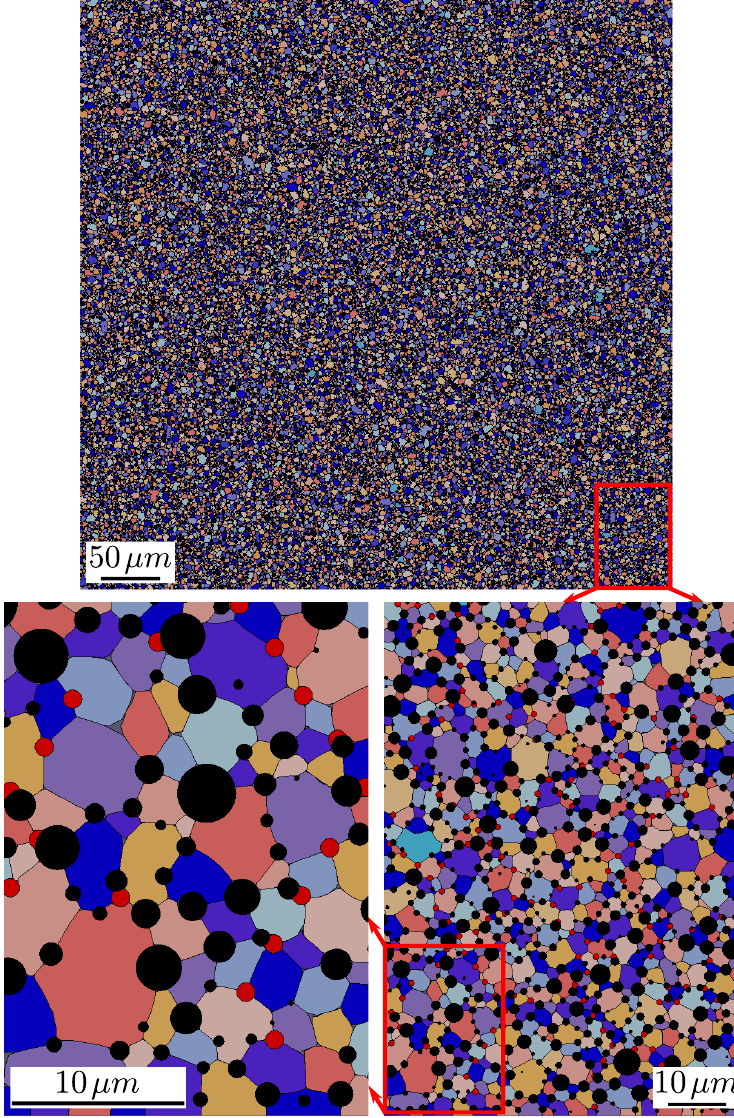
Figure 15. Initial state of the microstructure used in the simulations for the N 19 material with γ (cid:48) precipitates (black) and PPB particles